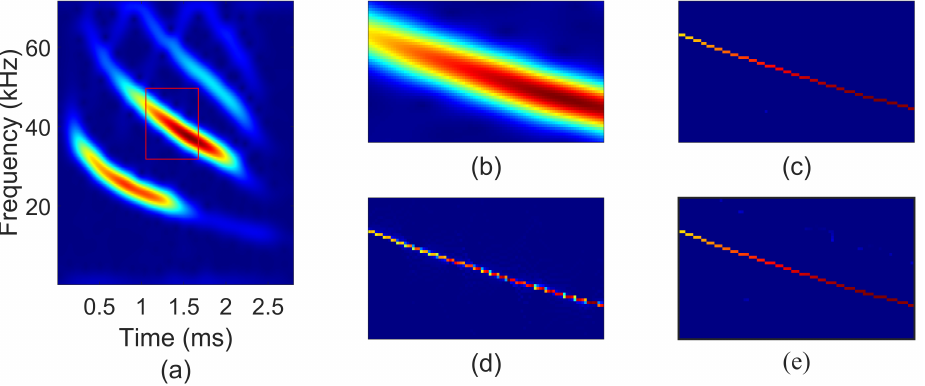
Figure 11. Results of different TFAs. ( a ) STFT result. ( b ) Zoom of the STFT result. ( c ) Zoom of the MSRT result. ( d ) Zoom of the SST2 result. ( e ) Zoom of the SET2 result.